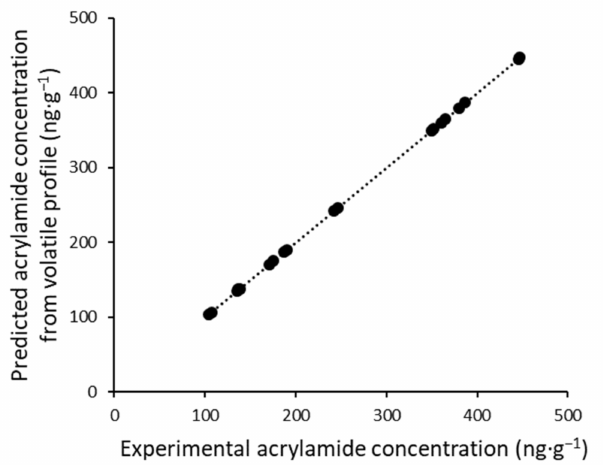
Figure 3. Predicted acrylamide concentration by volatile profile vs. experimental